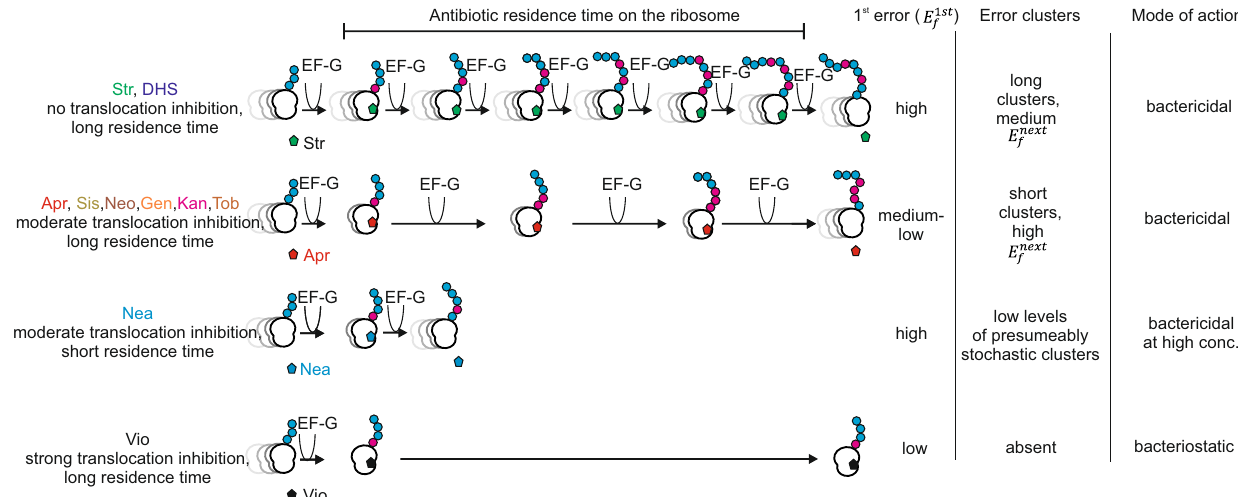
Fig. 6 Model of AGA-induced error cluster formation. The ef fi cacy of an AGA in inducing proteotoxic error clusters depends on its ability to bind and induce the 1 st error, its residence time on the ribosome, and the inhibitory effect on translocation. Str, which does not affect translocation, and its derivative DHS, induce frequent single errors and remain bound to the ribosome for many elongation cycles, resulting in formation of long error clusters. AGAs that have a moderate inhibitory effect on translocation induce short clusters, because they tend to dissociate after only a few slow translation rounds. Neamine has a high misreading potential, but dissociates rapidly from the ribosome, resulting in low levels of presumably stochastic error clusters which are thus not distance dependence. Viomycin stops translocation which terminates translation by ribosomes that have the antibiotic bound and hence prevents formation of the error